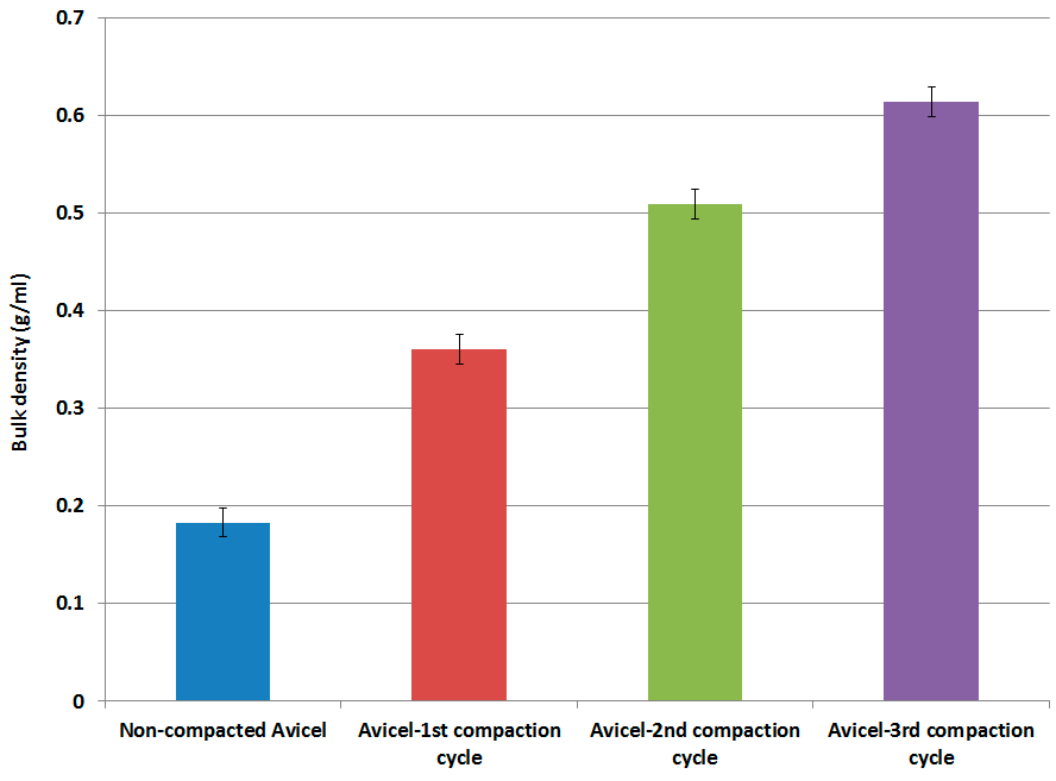
Figure 2. Bulk density as a function of compaction cycles.